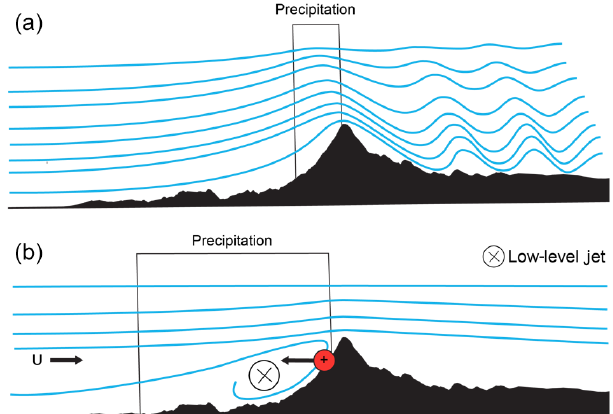
Figure 7. Schematic illustration of the interaction between the at- mospheric air flow and the Andes. (a) Linear mountain flow re- sponse ( ˆ H < 1) leads to strong uplift and precipitation along the western slopes. (b) The air flow is blocked by the topography ( ˆ H ≥ 1), and the resulting pressure gradient (indicated by the red circle) at the western slope slows down the upstream flow. The im- balance between the large-scale pressure gradient and Coriolis force leads to a northerly low-level jet, which reduces and shifts the up- lift motions upstream. This mechanism enhances precipitation in the Precordillera range, while reducing precipitation at the western slopes of the